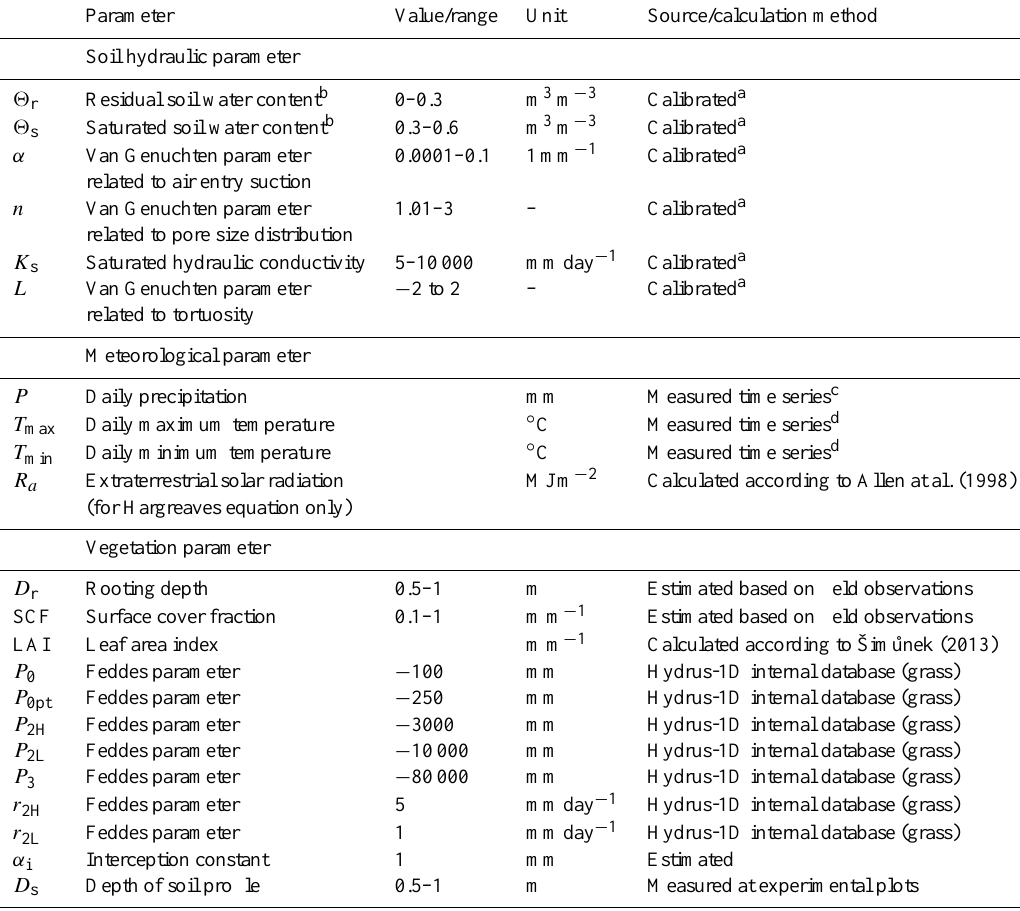
Table 2. Parameters and value ranges for Hydrus-1D modelling.